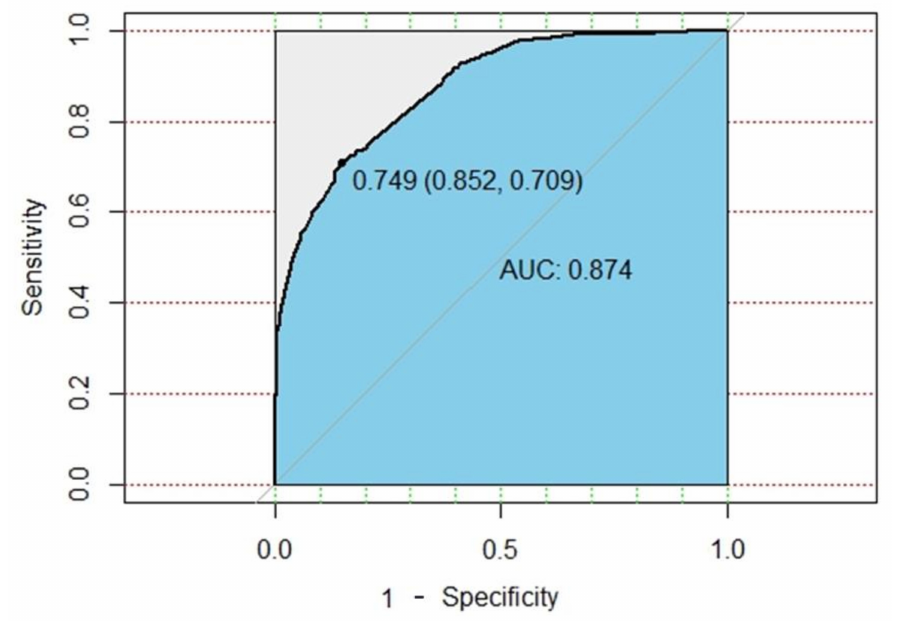
Figure 4. ROC plot of DNN model.